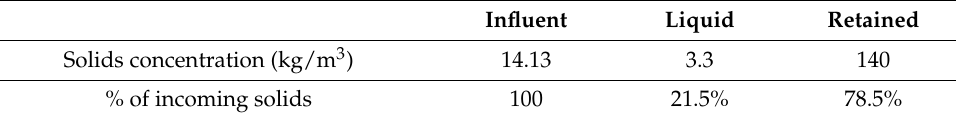
Table 5. Solid distribution in a solid